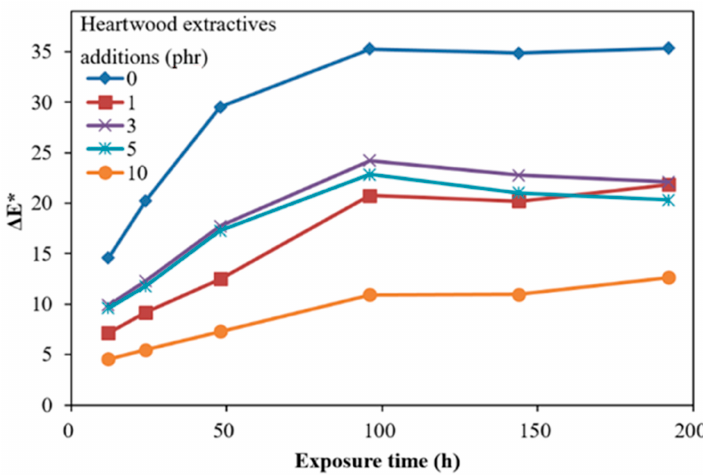
Figure 2. Time-dependent color difference ( ∆ E *) of ROL films with various A. confusa heartwood extractive additions after UV